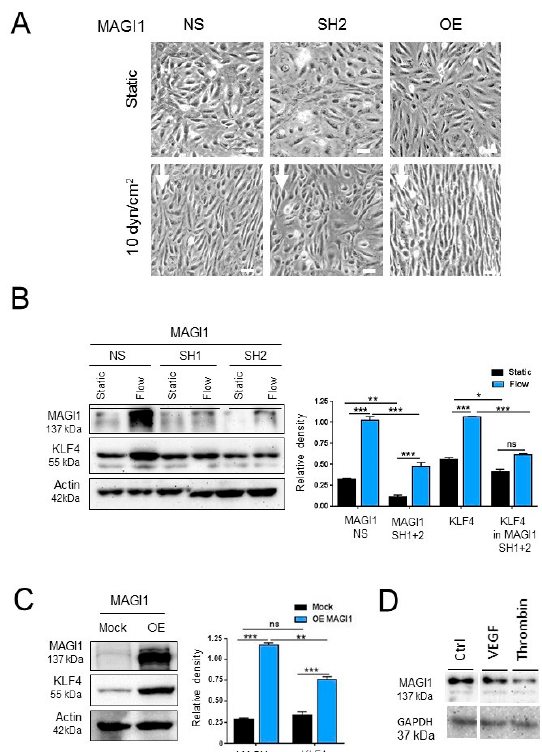
Figure 2. MAGI1 mediates endothelial cell alignment and KLF4 expression upon exposure to fluid shear stress. ( A ) Control HUVEC (NS), HUVEC with silenced (SH) or overexpressed (OE) MAGI1 were exposed to laminar shear stress (10 dyn / cm 2 ) in the orbital shaker model (OS) for 24 h. MAGI1 SH perturbs, while MAGI1 OE facilitates alignment. Arrows: direction of flow. N = 5. Scale bar = 20 µ m. ( B ) Western blotting analysis of control (NS) and MAGI1 silenced (SH1 and SH2) HUVEC under static and orbital flow conditions (OS) for 24 h. MAGI1 silencing prevents KLF4 induction under shear stress. N = 3. ( C ) Western blotting analysis of control (Mock) and MAGI1-overexpressing (OE) HUVEC under static conditions. N = 3. ( D ) Western blotting analysis of cultured control HUVEC (Ctrl) or HUVEC exposed to VEGF (100 ng / mL for 24 h) and thrombin (10 U / mL for 30 min). Beta actin or GAPDH are shown as loading controls. Relative band quantifications by densitometry of multiple experiments are shown next to the blots. * p < 0.05; ** p < 0.01; *** p < 0.001.